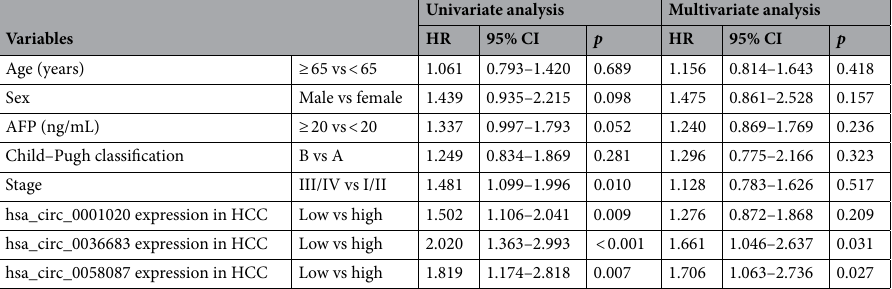
Table 2. Univariate and multivariate cox proportional hazards regression analysis for recurrence free survival. HR hazard ratio, CI confidence interval, AFP alpha-fetoprotein.